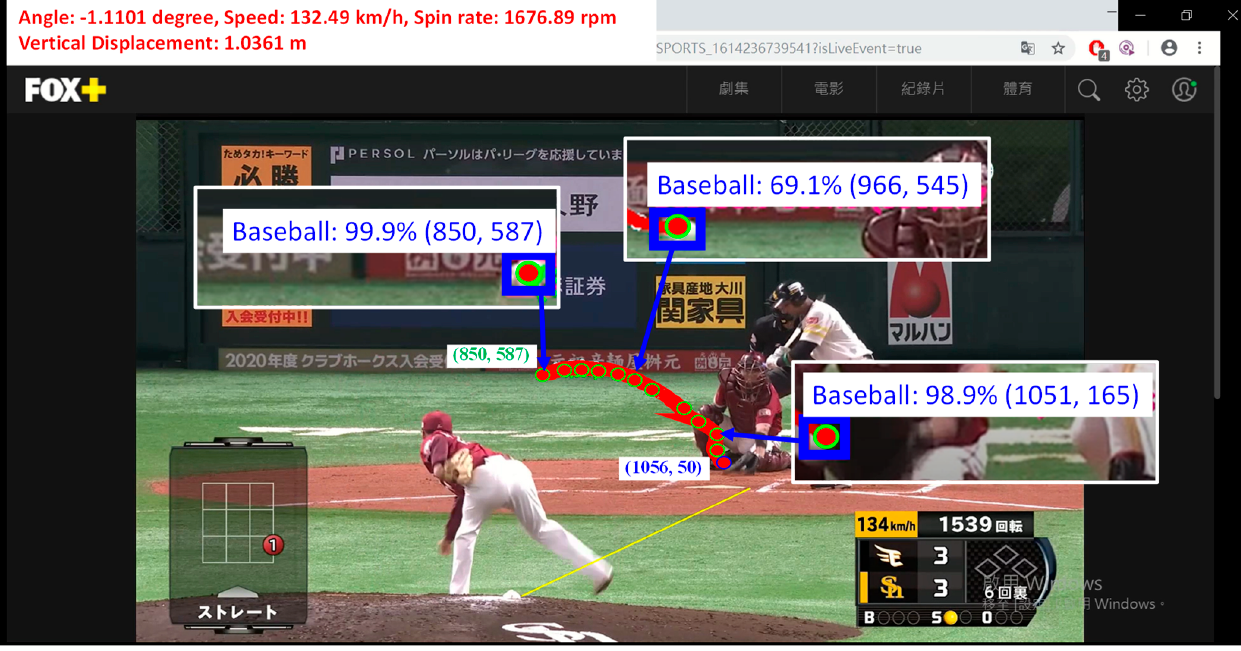
Figure 10. Automatic measurement result for a change-up ball. Table 3. Measurement results of the pitched-baseball trajectories.